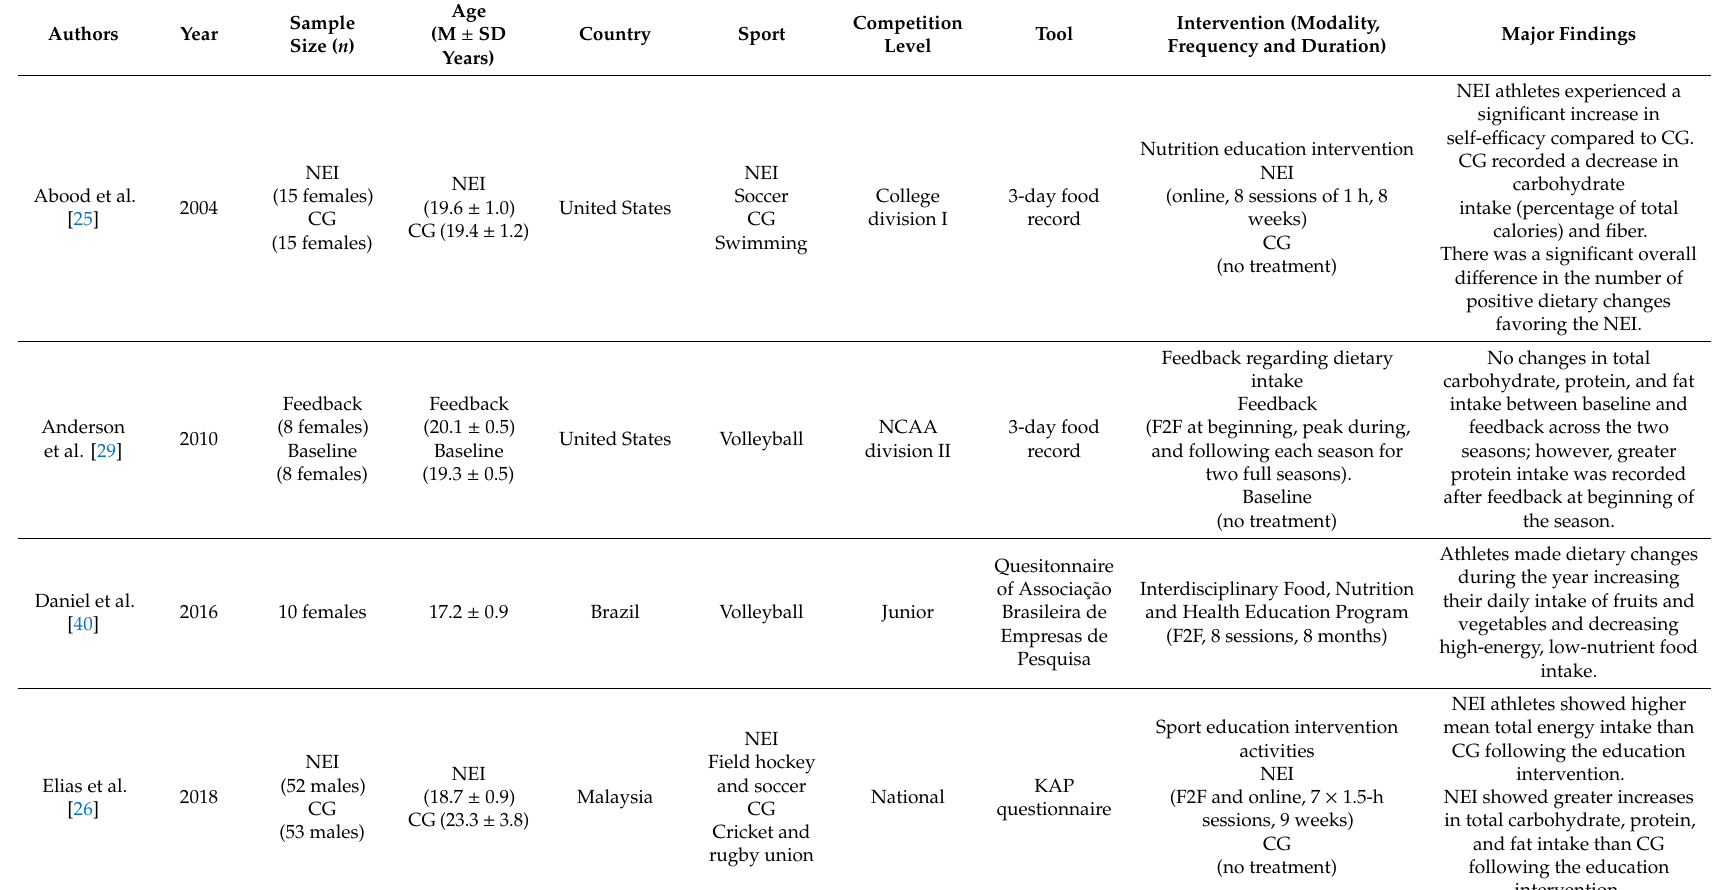
Table 1. Characteristics and major findings of the studies analyzing the e ff ect of nutrition education interventions on eating habits in team sport